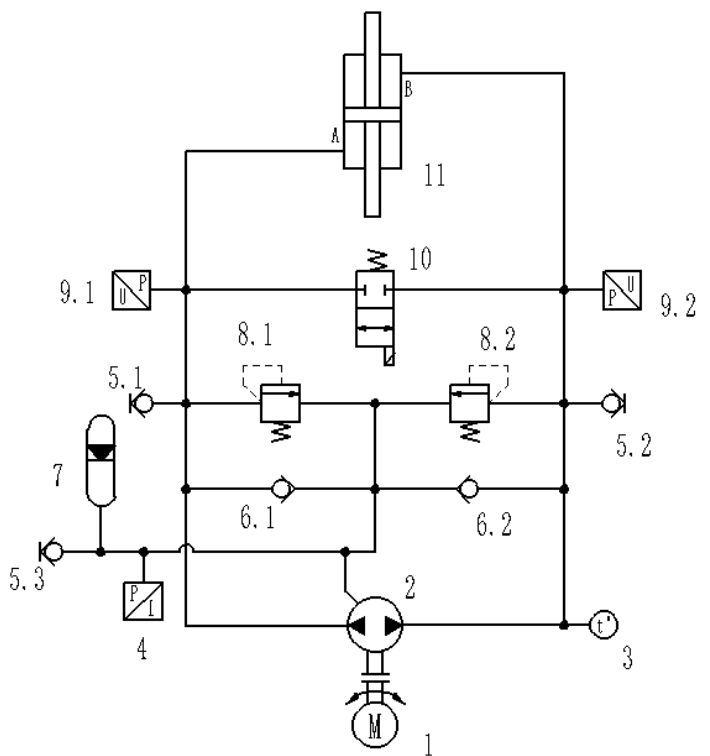
Figure 1. Schematic diagram of the DDVC electro-hydraulic servo system. 1, servo motor; 2, positive displacement pump; 3, temperature sensor; 4, pressure relay; 5, pressure joint; 6, check valve; 7, oil replenishment accumulator; 8, relief valve; 9, pressure sensor; 10, unloading valve; 11, symmetrical hydraulic cylinder.